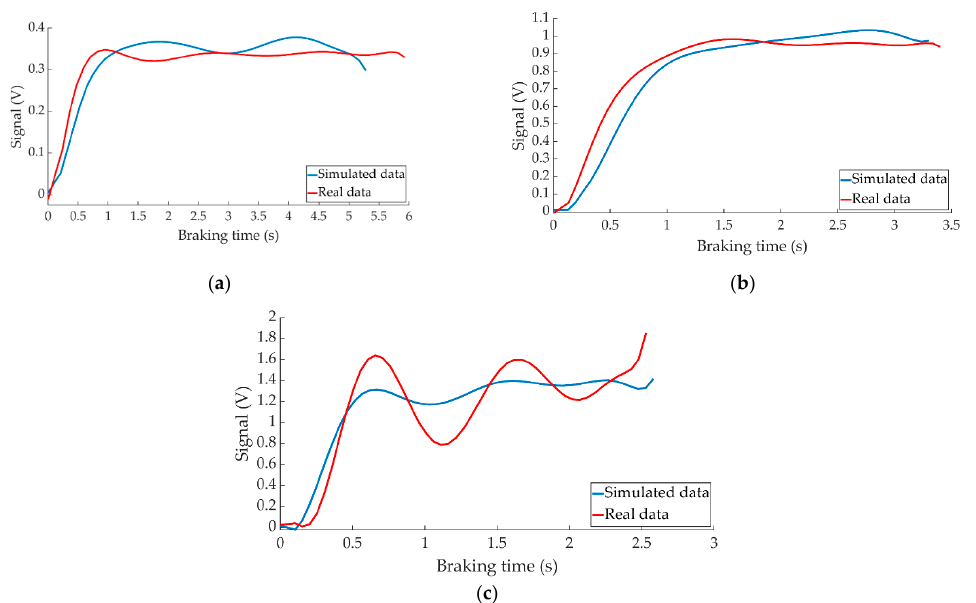
Figure 25. Comparison between the ANN-simulated data and actual data collected by the left pressure sensor for braking at a speed of 70 km/h for the type: ( a ) maintained, ( b ) progressive and ( c )